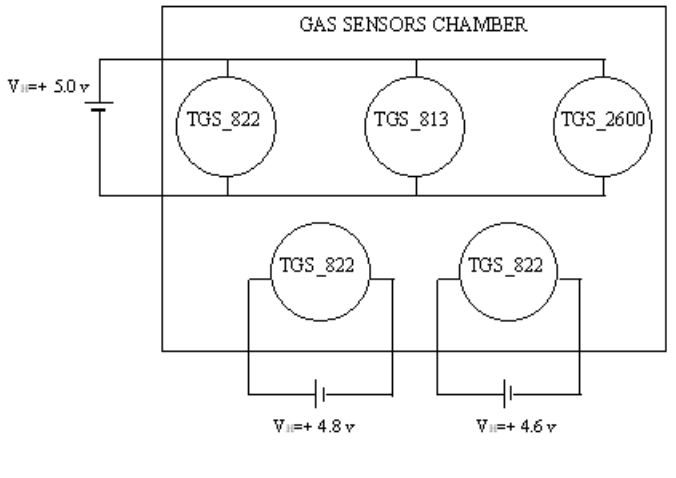
Figure 2. Block diagram of the sensors heater voltage